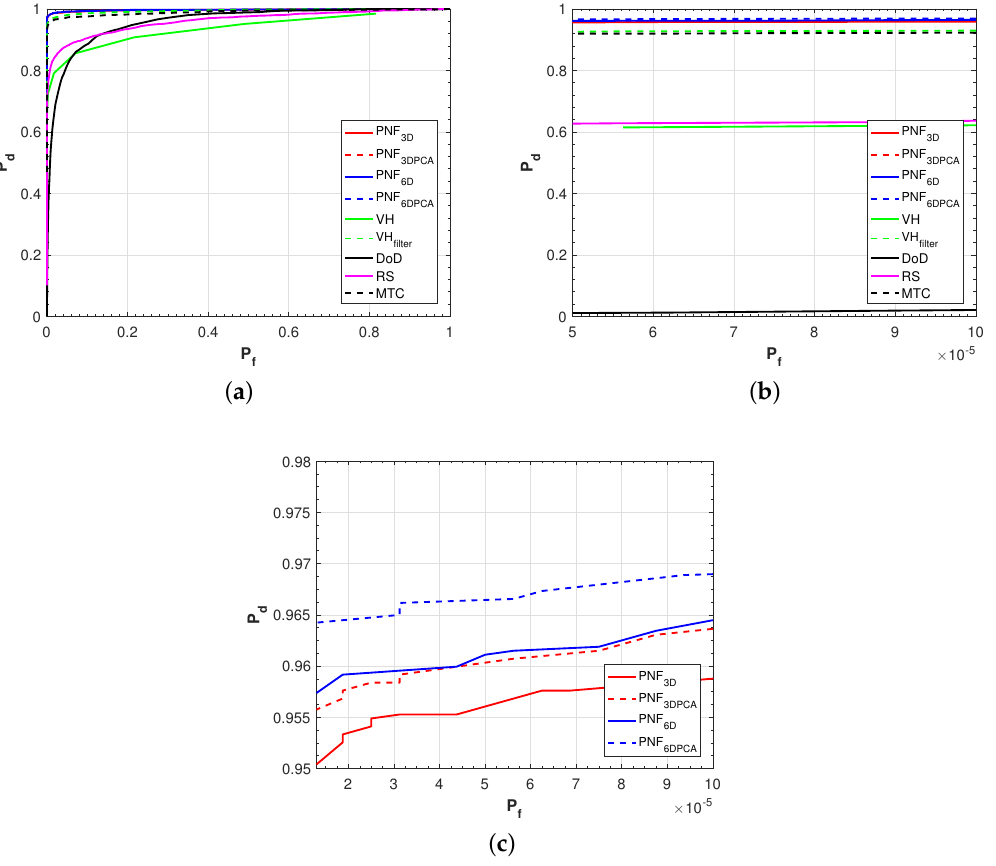
Figure 9. ROC curves. ( a ) the ROC curves ( P f belongs to [0, 1]); ( b ) zoom in on the P f ([0, 10 − 4 ]); ( c ) zoom in on the ROC curves of PNF X